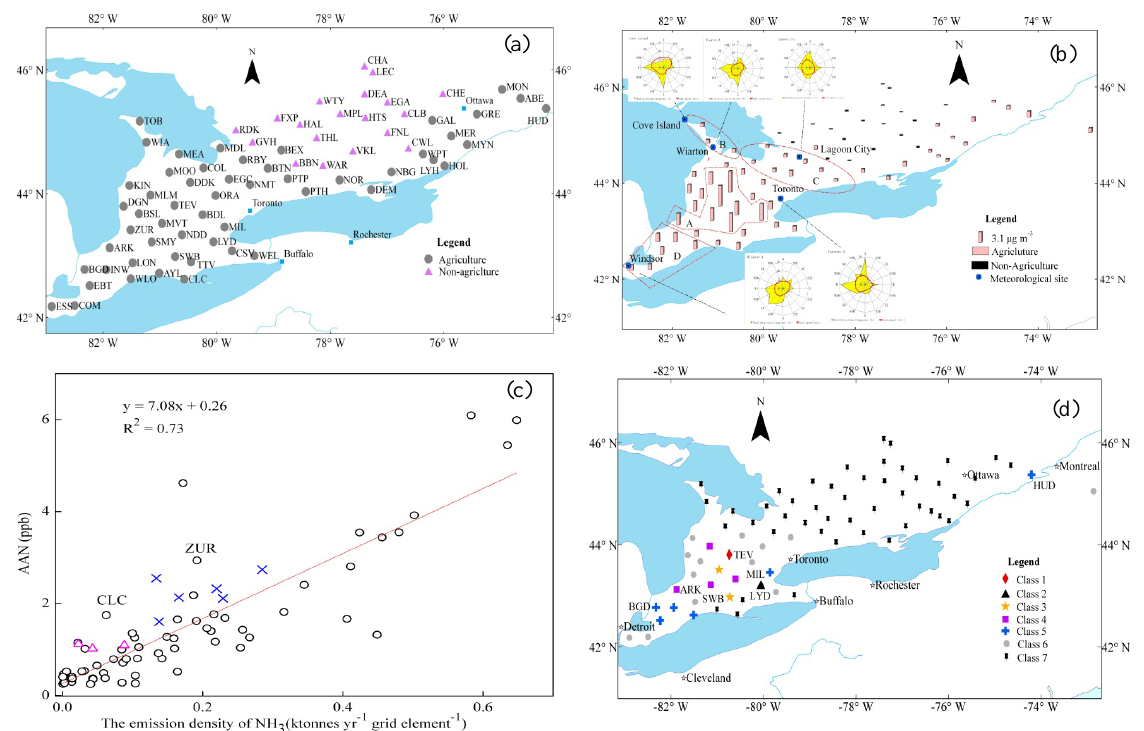
Fig. 1. (a) location and symbol of the 74 sampling sites across southern Ontario; (b) geographical distributions of annual average NH 3 (AAN) with superimposed wind rose at five meteorological stations; (c) correlation between AAN and gridded emission. Pink triangle and blue cross are Zones B and D sites, respectively, shown in Fig. 1b; and (d) classification of the 74